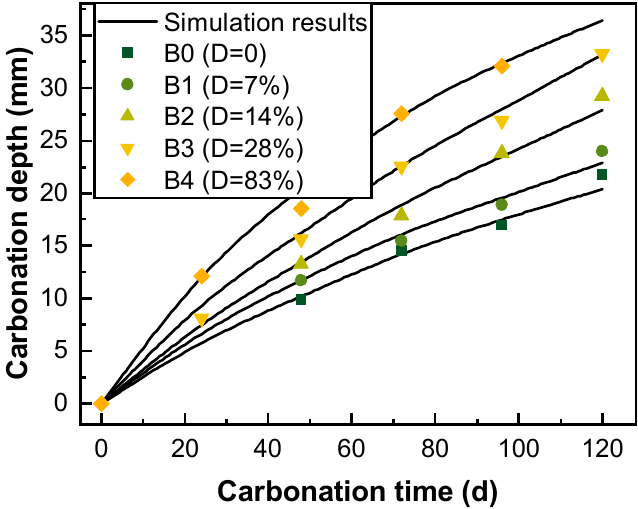
Figure 16. Comparison between numerical simulation and experimental results of carbonation depth of RC beams.